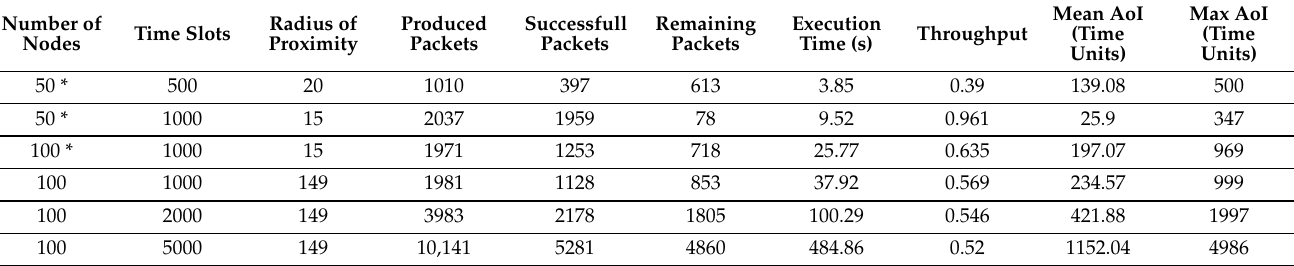
Table 6. Initial results for FRESH-near-v1.